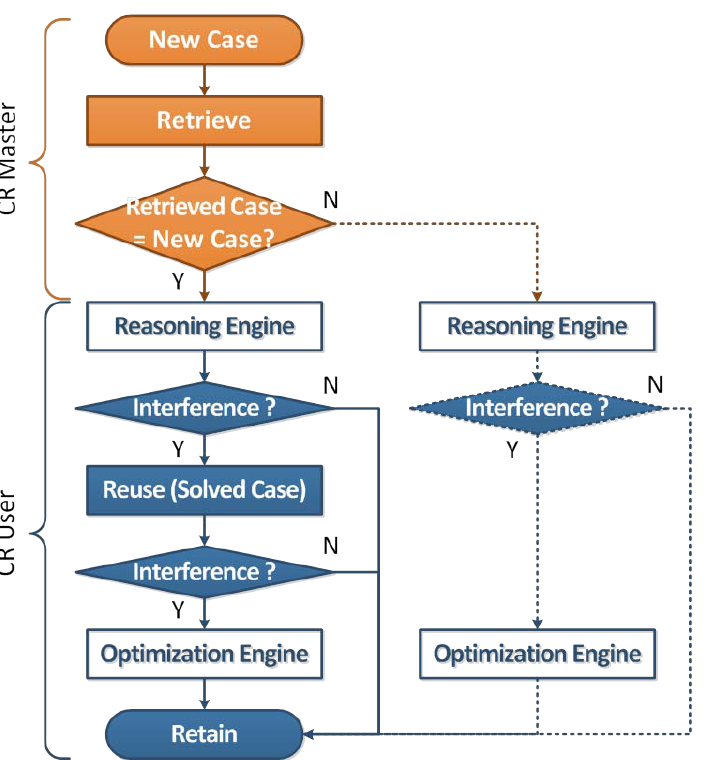
Figure 5. Flowchart of the intelligent dynamic real-time spectrum resource management using case-based reasoning.